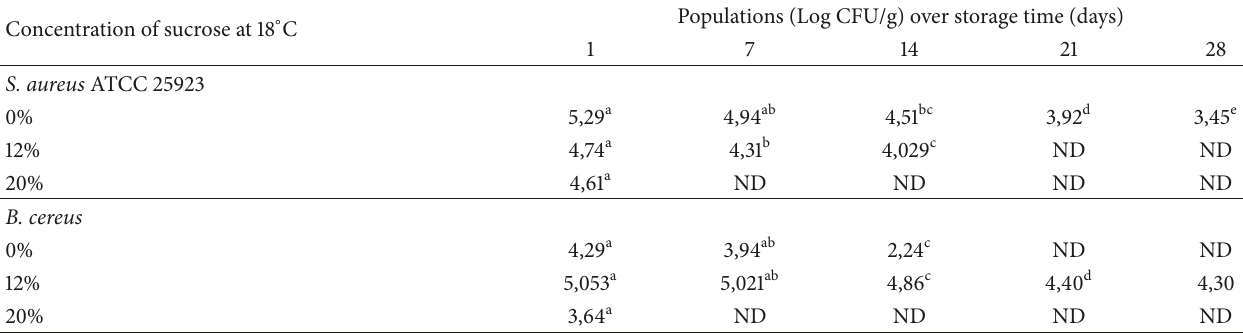
Table 4: Populations of S. aureus ATCC 25923 and B. cereus in macadamia butter at varying concentrations of sugar stored at 18 ∘ C. Concentration of sucrose at 18 ∘ C